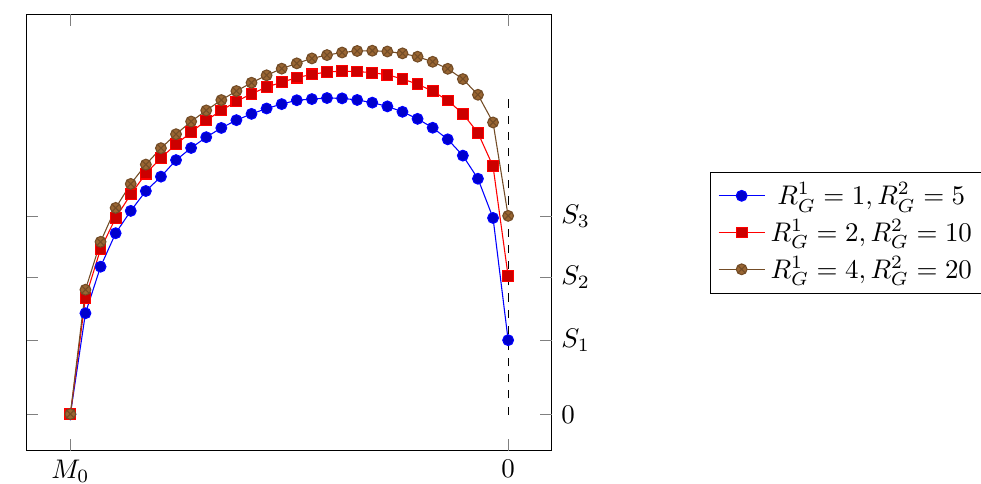
Figure 3. Entropy of the entanglement between matter and space, as a function of the decreasing mass of the evaporating BH. The initial and final points of this curve are in exact correspondence with the initial and final points of the Page curve. The plot here is for two topologies and three cases. The more microscopic realizations of macroscopic classical geometries are allowed, the higher the residual entropies. Here, S 1 = 0.77, S 2 = 1.43, S 3 = 2.06. Figure taken from